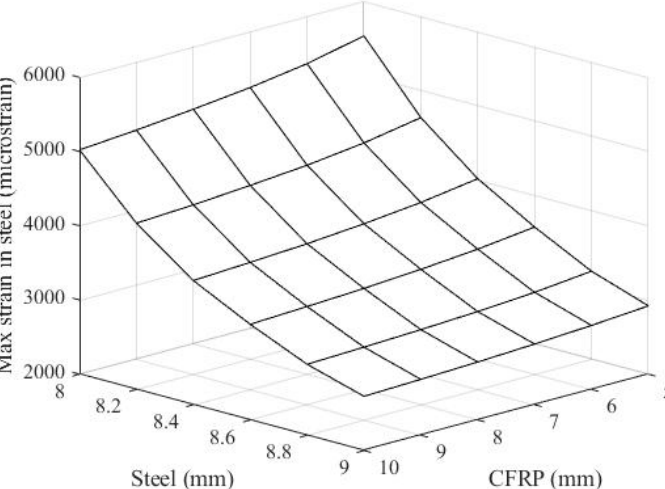
Figure 6. The maximum strain in steel with regard to the thicknesses of both steel slab and CFRP pipe.